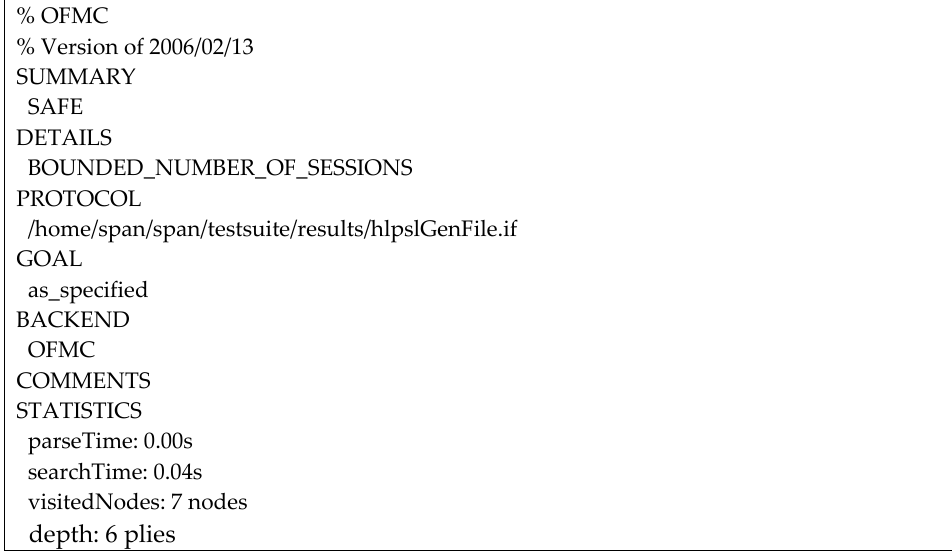
Figure 12. On-the-Fly-Model-checker (OFMC) analysis result.